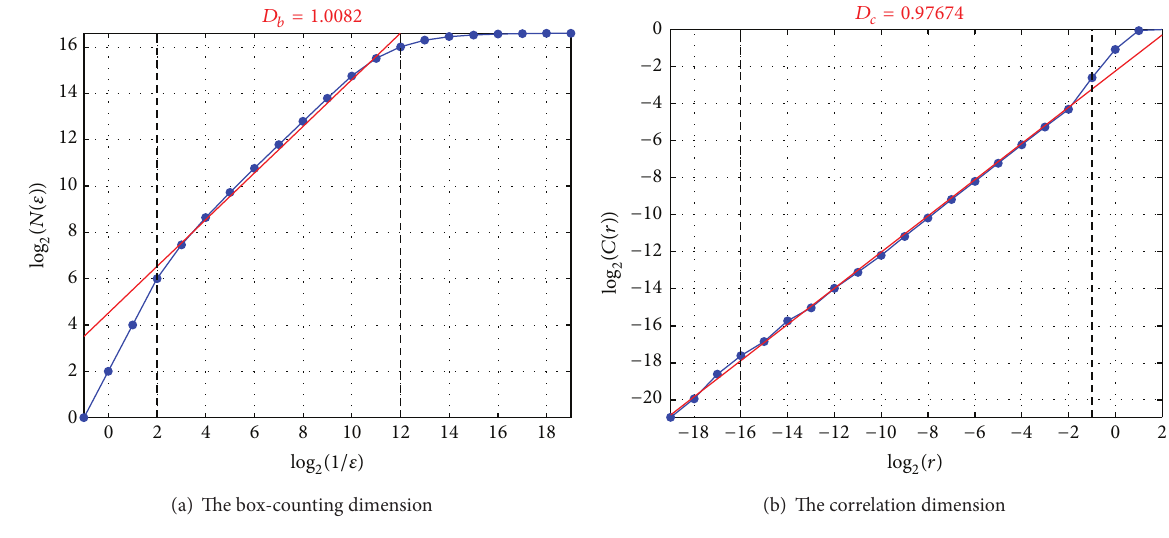
Figure 6: The fractal dimensions of the attractor of the 𝑓 𝑟 map.